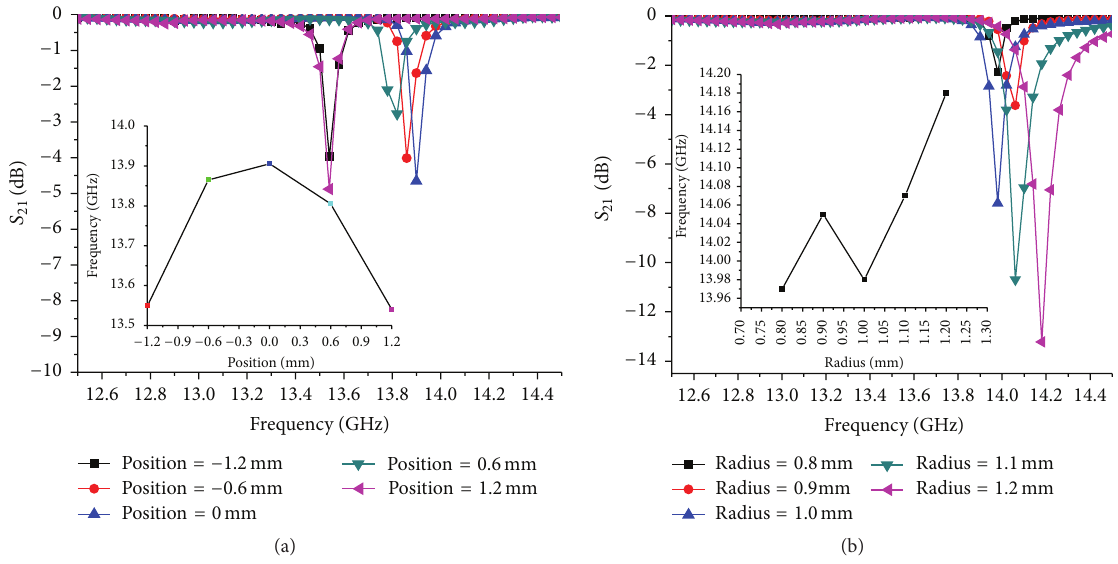
Figure 3: Simulation results of the HMSIW resonator. (a) Changes of frequency with different positions (in 𝑦 -axis). (b) Changes of frequency with different radiuses.